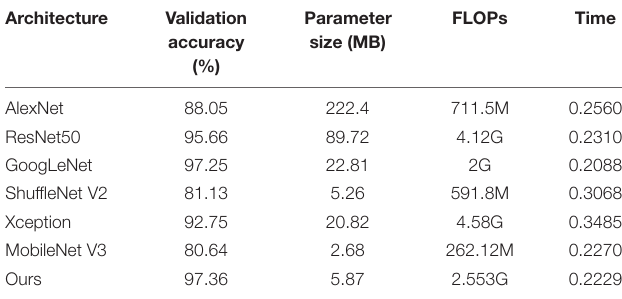
TABLE 5 | Performance comparison of each